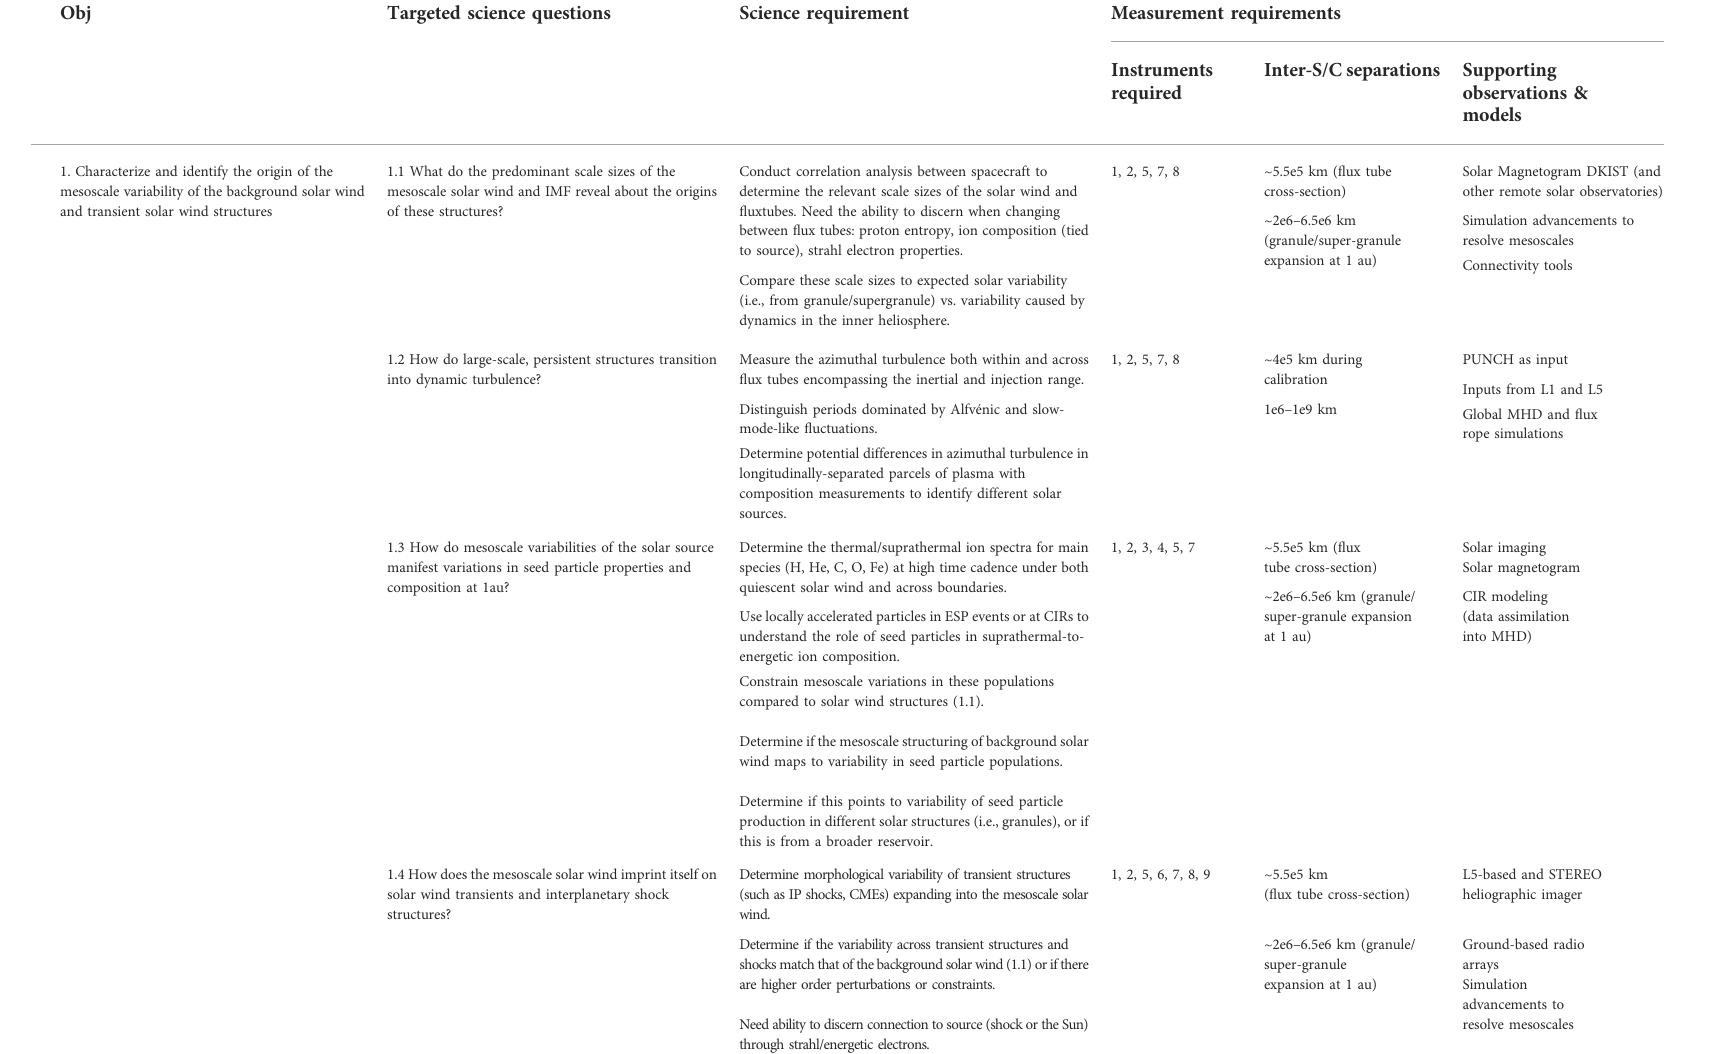
TABLE 1 InterMeso STM. Instruments: 1) bulk solar wind, 2) thermal ion composition, 3) suprathermal ion composition, 4) energetic ion composition, 5) low-energy electrons, 6) energetic electrons, 7) magnetic fi eld, 8) radio waves, and 9) hard X-rays.